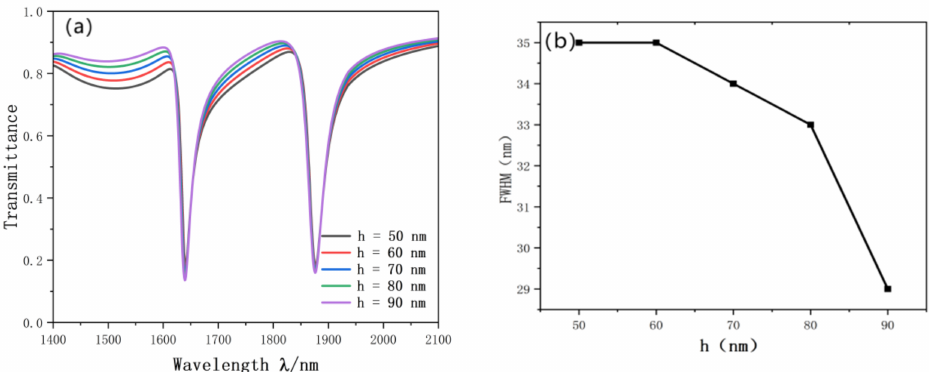
Figure 11. ( a ) Transmission spectrum of h variation; ( b ) trends in FWHM.